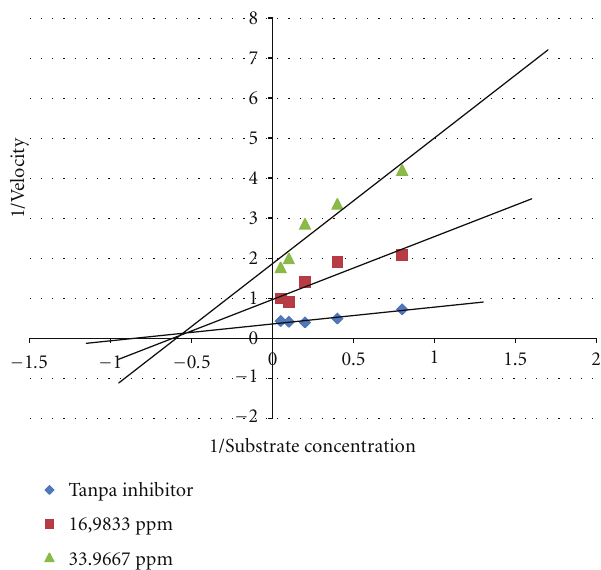
Figure 2: Lineweaver-Burke plot of the reaction α -glucosidase in the presence of 80% ethanol extract from Garcinia kydia Roxb. Leaves.